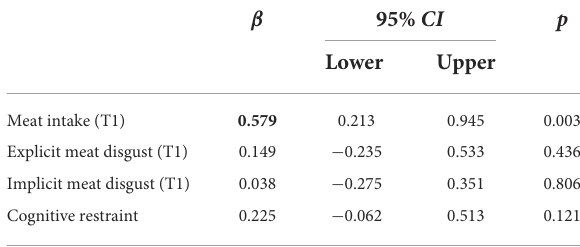
TABLE 4 Coefficients from multiple regression on meat intake during